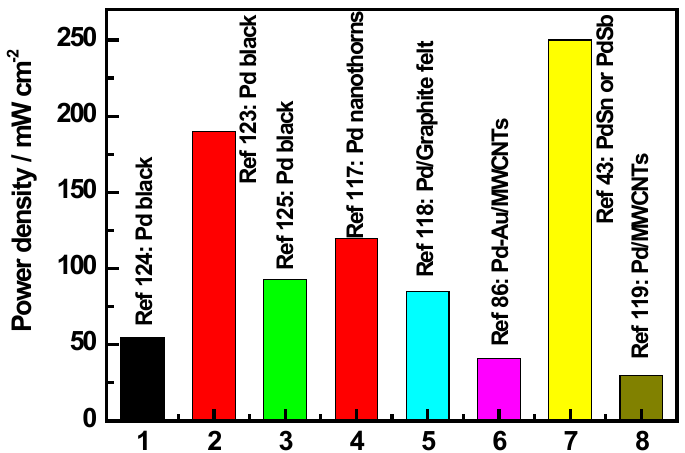
Figure 6. Comparison of the power density of the single fuel cell performance with selected